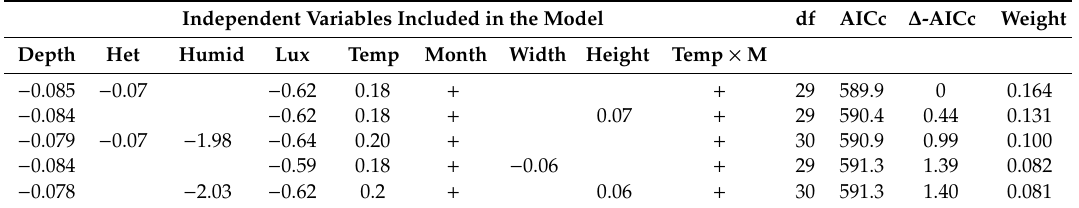
Table 2. Five best corrected Akaike Information Criterion (AICc) models relating crane flies presence within cave sectors. We considered as dependent variable the presence of the species. We used as independent variables: sector Width, Height, Depth, wall heterogeneity (Het), sector humidity (Humid), illuminance (Lux) and temperature (Temp), Month of survey and its interaction between microclimatic features ( × ). For each continuous variable, the regression coe ffi cient is reported if the variable is included into a given model. For categorical variables and interactions, + indicates that the variable or the interaction is included into the model. If not shown in table, the variables were not included in the first five best AICc models. The best model is highlighted in bold.